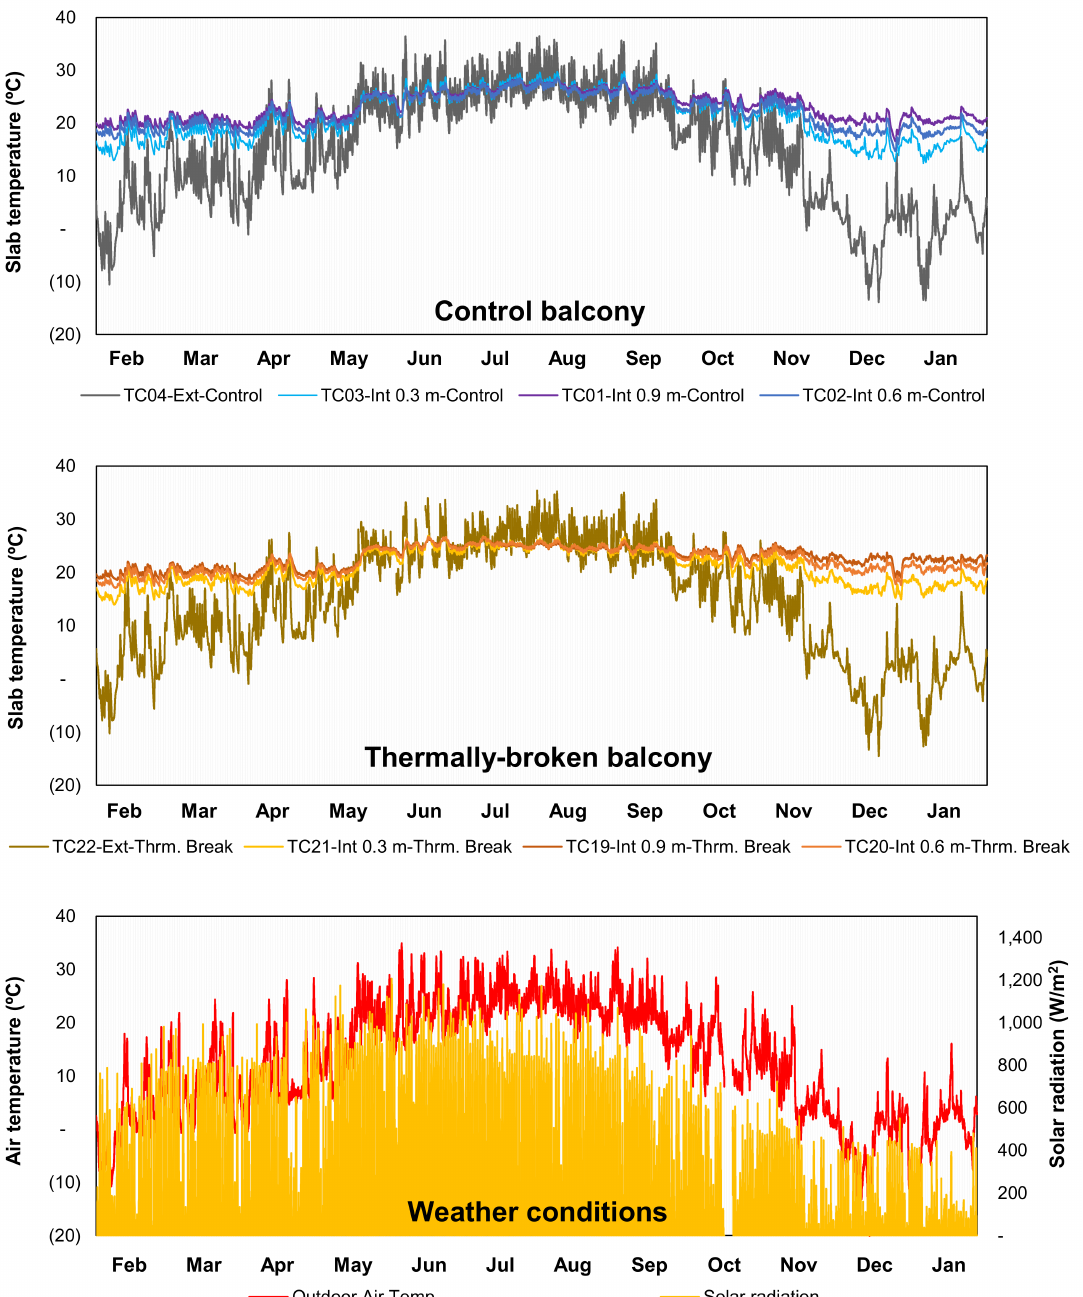
Figure A1. Experimental data for balcony pair